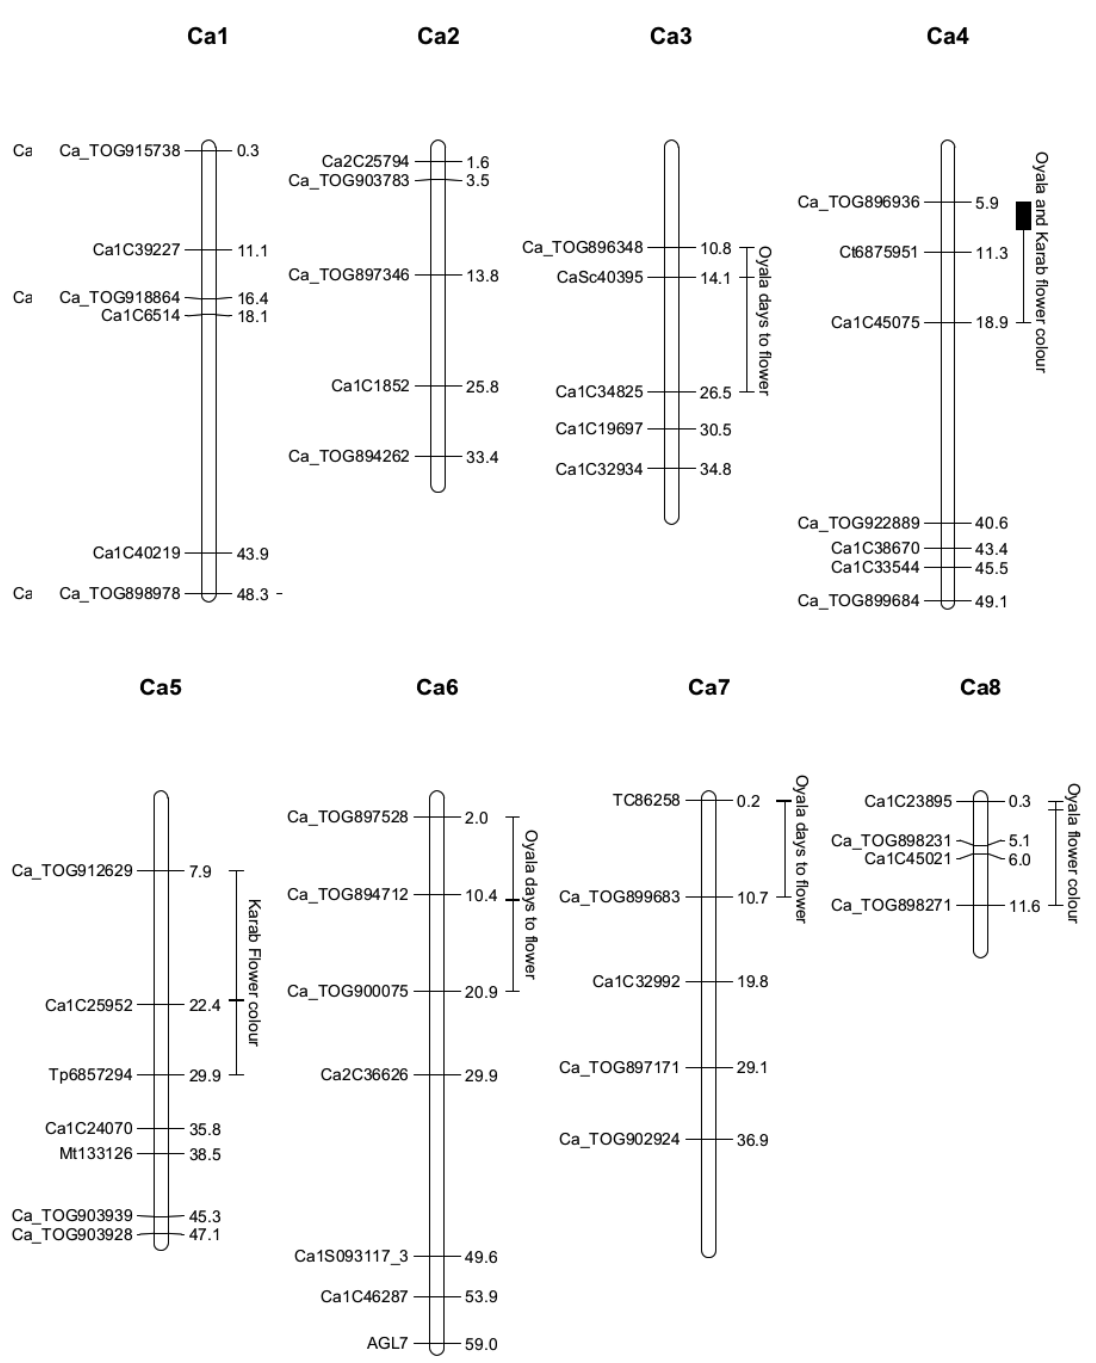
Figure 3. Genetic map showing quantitative trait loci for flowering time and flower color identified in the Gokce × Oyali and Gokce × Karab families. Chromosomes (linkage groups) are shown as white vertical bars with genotyped SNP positions marked with horizontal dashes and labels to the left of chromosomes. QTLs for each family and trait are shown as vertical lines to the right of the corresponding chromosome with a horizontal dash or bar showing the QTL LOD peak or peak range between the two families.